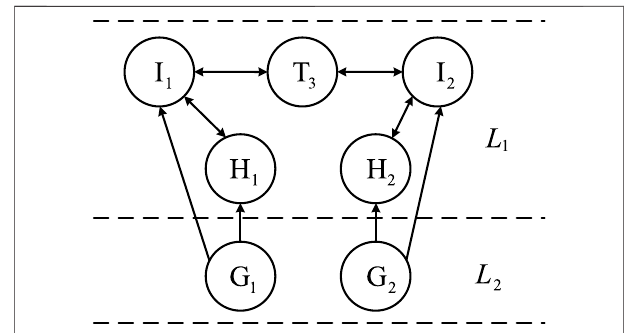
FIGURE 4 | Model diagram of the system structure.